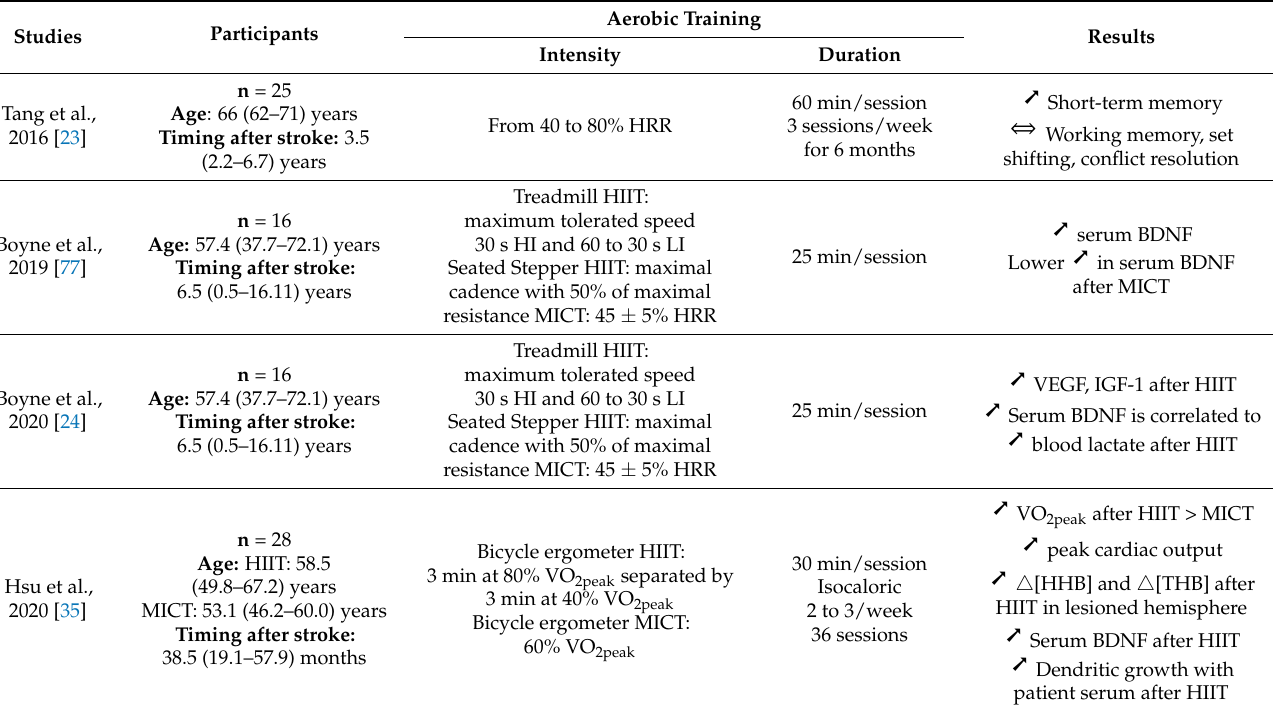
Table 1. Summary of aerobic training protocols and their effects on cognition in stroke patient.